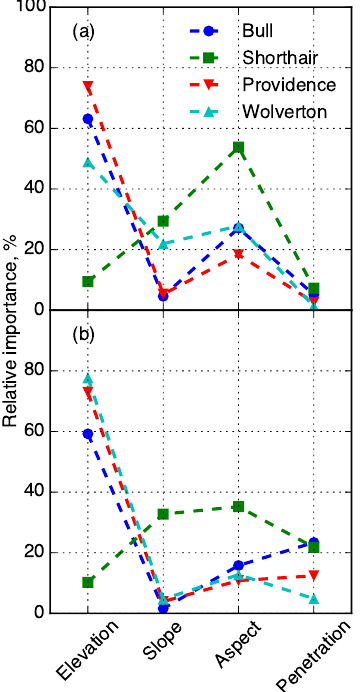
Figure 8. Relative importance of each physiographic variable in predicting the snow depth from each site for (a) open area and (b) under-canopy area.